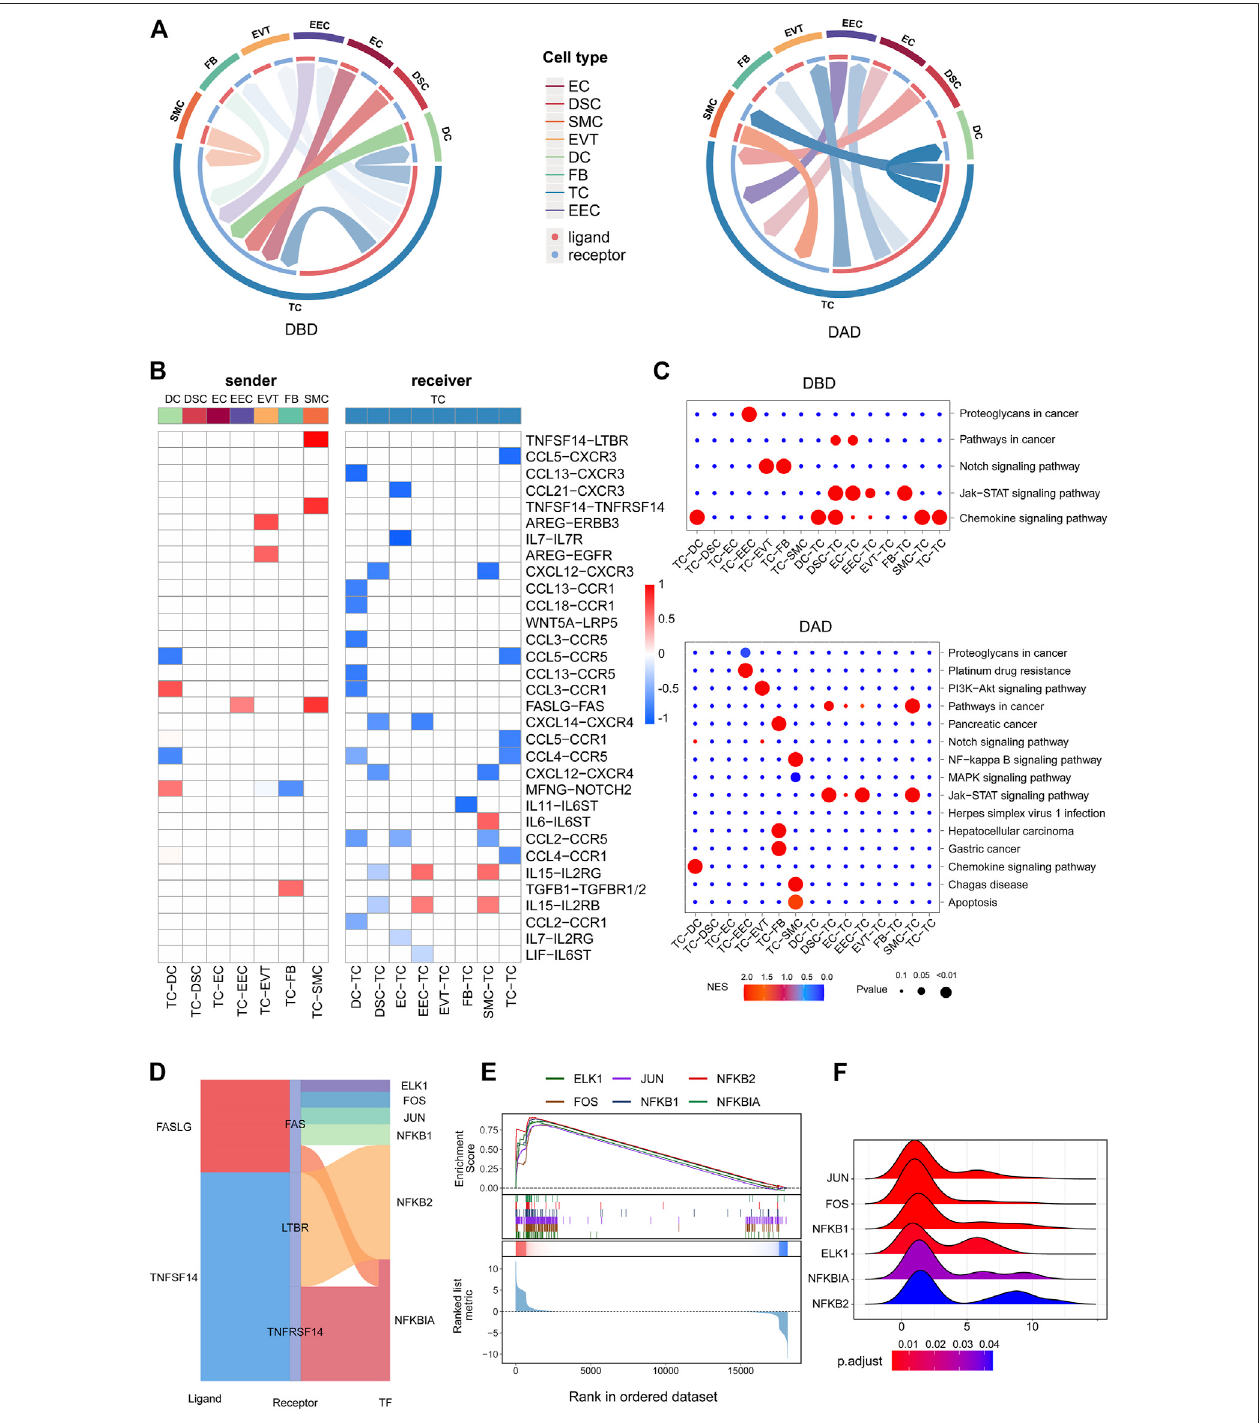
FIGURE 4 | Intercellular communication related to TCs. (A) Circos plot of intercellular communication related to TCs in DBD and DAD. (B) Differential intercellular communication related to TCs; red represents signi fi cantly increased intercellular communication in DAD; blue represents signi fi cantly decreased intercellular communicationinDAD. (C) PathwayactivityanalysisofdifferentialintercellularcommunicationrelatedtoTCs. (D) SankeyplotofthreeintercellularsignalsrelatedtoTCs. (E) EnrichmentanalysisofsixTFs(thetargetgenesetoftheTF)downstreamofthethreeintercellularsignalpathways. (F) RidgeplotofthedensitydistributionofFC of TGs for the six TFs.